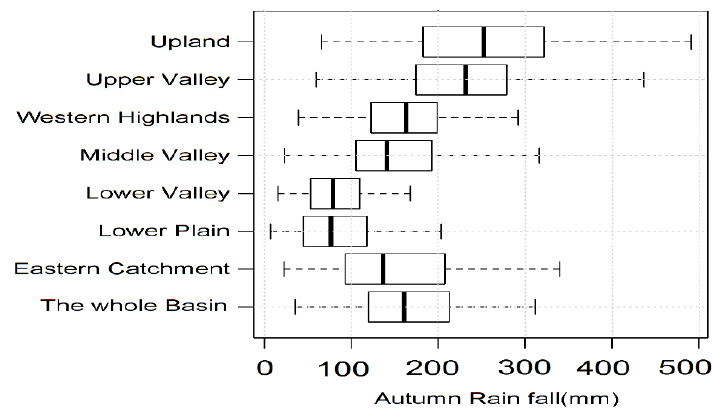
Figure 11. Box plot showing the variability of autumn rainfall over the study areas for the period 1900 – 2016.